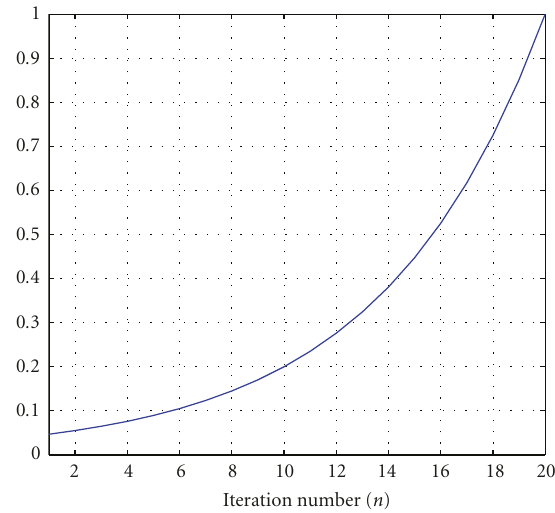
Figure 5: β -updates for Z = 20 iterations.